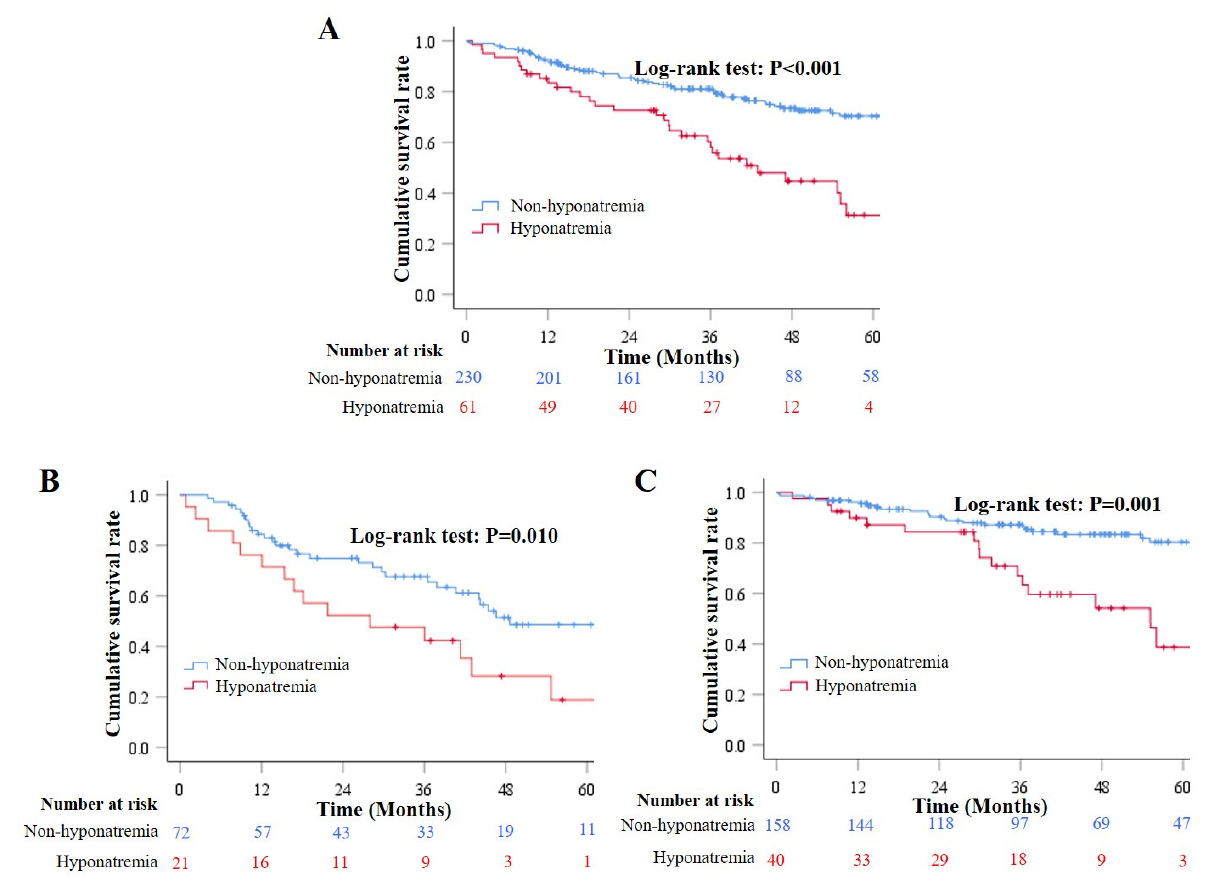
Figure 3. Long-term survival according to the development of hyponatremia during hospitalizations. ( Panel A ): Kaplan–Meier curves showed the cumulative survival rates in overall patients who developed and did not develop hyponatremia during hospitalizations. ( Panel B ): Kaplan–Meier curves showed the cumulative survival rates in overall patients who developed and did not develop hyponatremia during hospitalizations in the HA group. ( Panel C ): Kaplan–Meier curves showed the cumulative survival rates in overall patients who developed and did not develop hyponatremia during hospitalizations in the control group. Table 4. Long-term outcome cohort—Characteristics of patients in the treatment study after